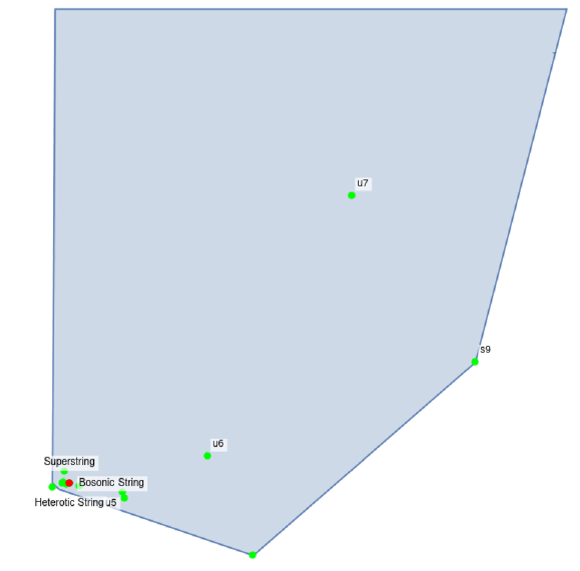
Figure 18 . The unitary polygon for ( a 8 , 0 , a 8 , 2 , a 8 , 4 ) of the graviton EFT. We see that the string theory EFTs are clustered near the low spin boundaries of the